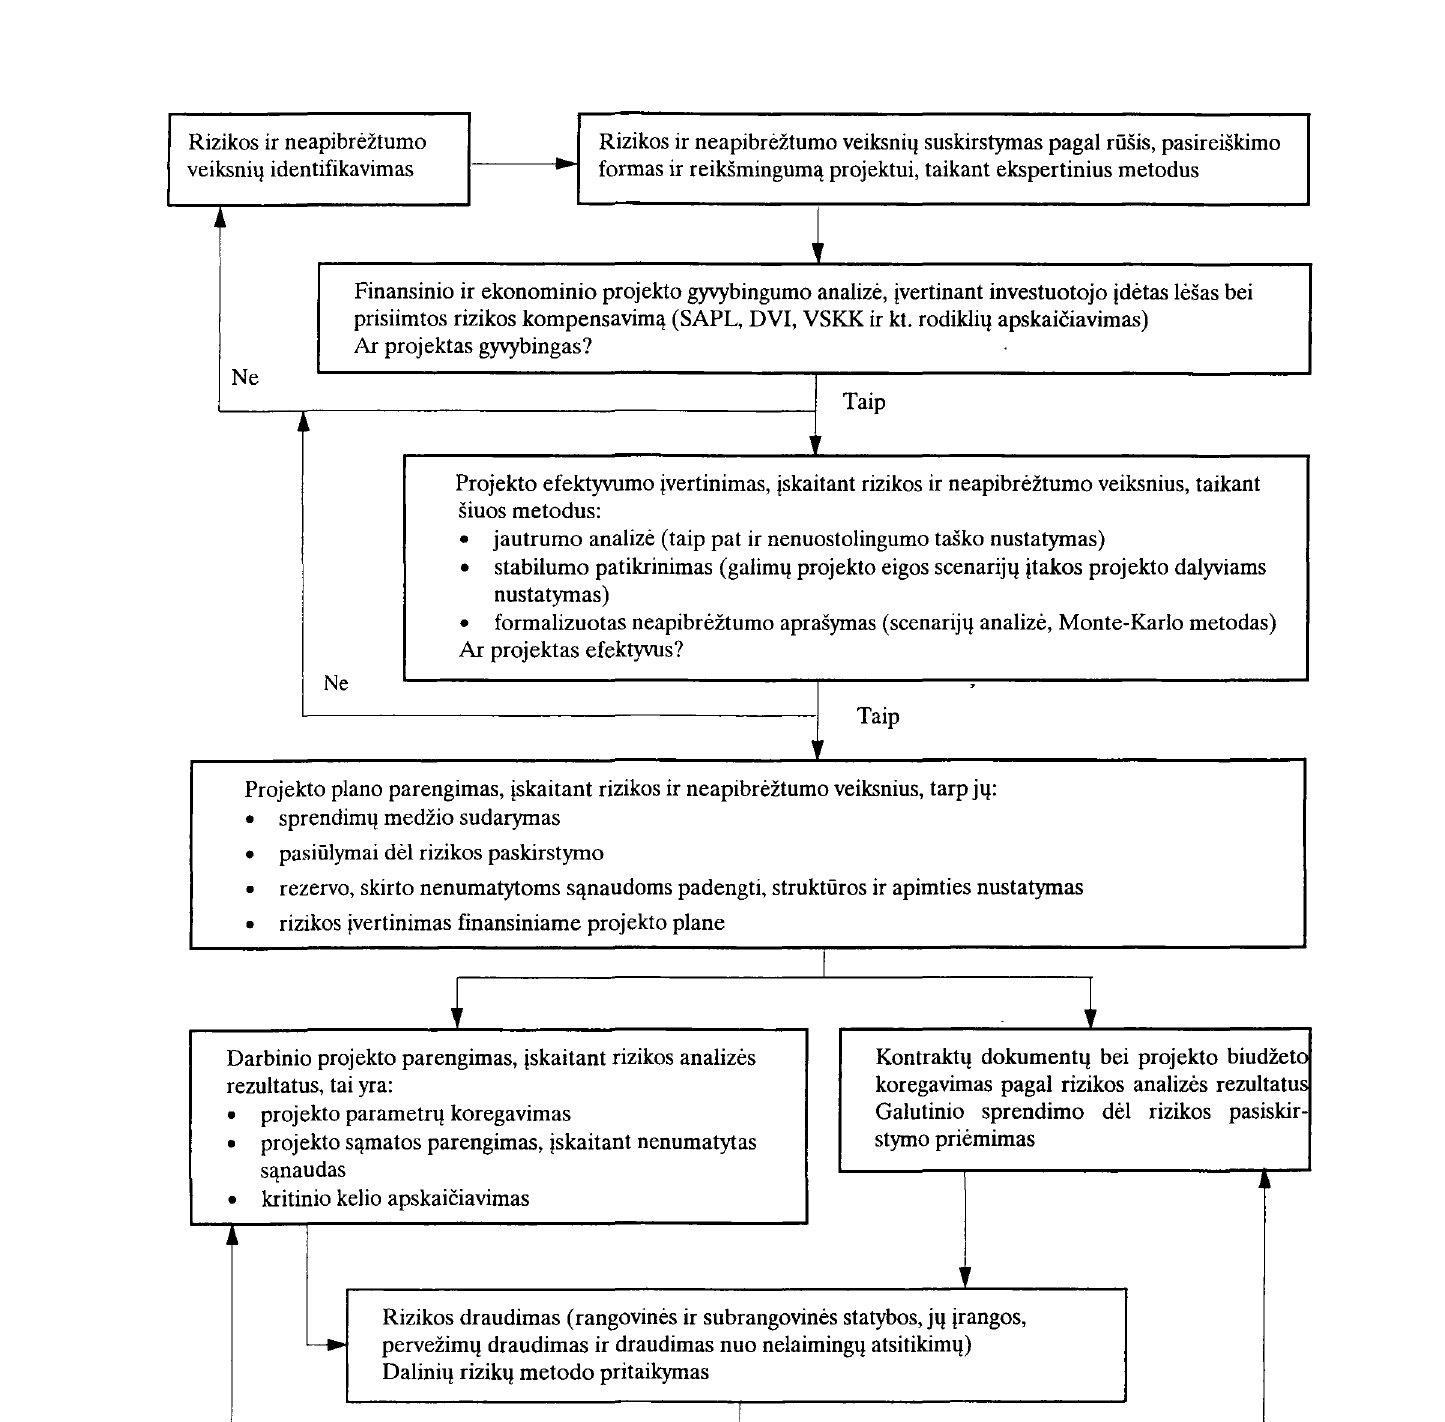
Fig 2. Model of risk management